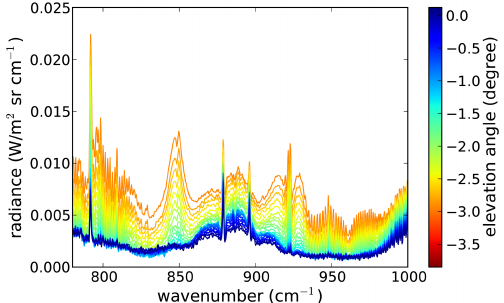
Figure 3. Spectra obtained by averaging over a detector row for a single GLORIA dynamics-mode measurement (Image 72, mea- sured at 15:04:49 UTC at 67 ◦ N, 7 ◦ E) after pixel weighting and filtering. Corresponding tangent altitudes are 9km (red) to 15km (dark